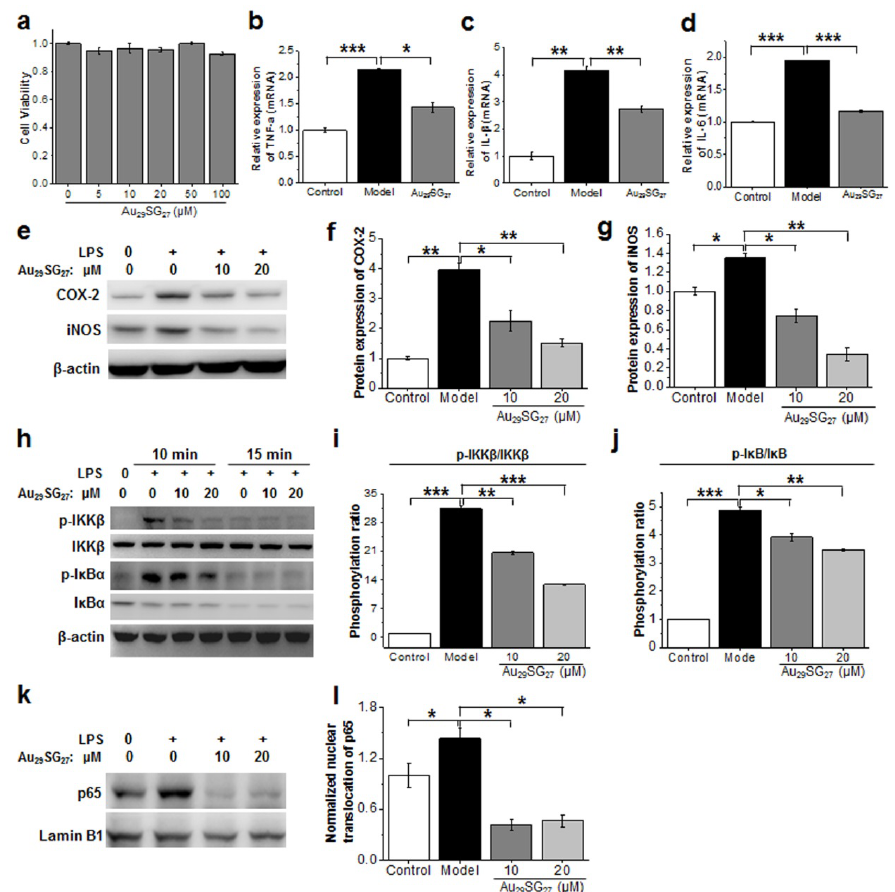
Figure 5. The e ff ect of Au 29 SG 27 on LPS (lipopolysaccharide)-induced inflammation and NF- κ B (nuclear factor kappa B) activation in HBZY-1 cells. ( a ) Cell viability of HBZY-1 cells after incubation with di ff erent doses of Au 29 SG 27 for 24 h. Data was presented as the mean of triplicate experiments. ( b – d ) The e ff ects of Au 29 SG 27 on the LPS-induced transcription of TNF- α (tumor necrosis factor alpha), IL-1 β (interleukin-1 beta) and IL-6 (interleukin-6) in HBZY-1 cells after 12 h incubation were detected by RT-qPCR (real-time quantitative PCR). GAPDH was used to normalize the data. Results were expressed as the mean of three repeated experiments ± standard deviation, * P < 0.05, ** P < 0.01, *** P < 0.001. ( e – g ) Western blotting detection ( e ) and densitometry analysis ( f , g ) of the expression of COX-2 (Cyclooxygenase-2) and iNOS (inducible nitric oxide synthase) at 12 h. β -actin was used as the internal control and was used to normalize the data. Data was presented as the mean of triplicate experiments. ( h ) Western blotting detection of the expression and phosphorylation of IKK β (I κ B kinase beta) and I κ B α (NF- κ B inhibitor alpha) in cytoplasm after incubation with LPS and Au 29 SG 27 for di ff erent times. β -actin was used as the loading control. ( i ) The relative phosphorylation ratio of IKK β (p- IKK β / IKK β ) at 10 min was densitometry-analyzed. Data was expressed as the mean ± standard deviation (n = 3). ( j ) The relative phosphorylation ratio of I κ B α (p-I κ B α / I κ B α ) at 10 min was densitometry-analyzed. Data was presented as the mean ± standard deviation (n = 3). ( k ) Western blotting detection of NF- κ B (p65) in the nucleus of HBZY-1 cells after incubation with LPS and Au 29 SG 27 for 12 h. Lamin B1 was used as the loading control. ( l ) The relative nuclear translocation of p65 was densitometry-analyzed. Lamin B1 was used to normalize the data. Data was presented as the mean ± standard deviation (n = 3). * P < 0.05, ** P < 0.01, *** P <